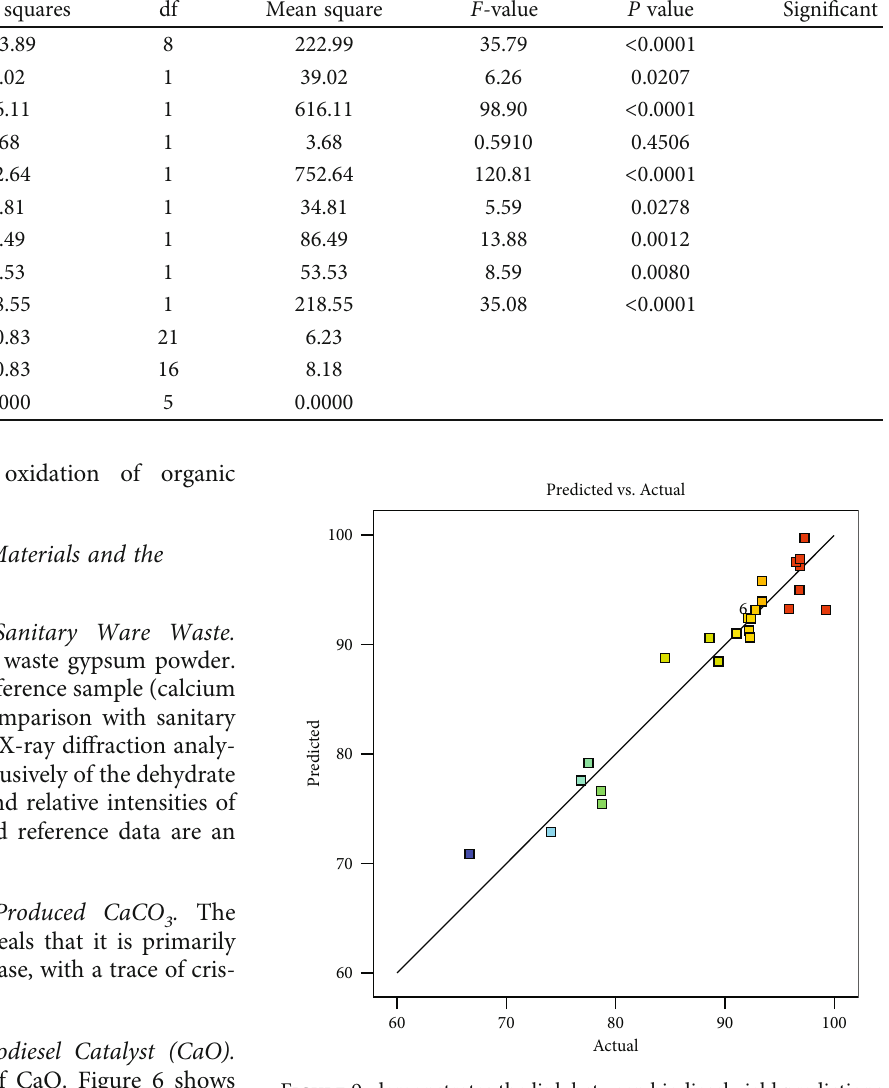
Figure 9: demonstrates the link between biodiesel yield predictions and experimental